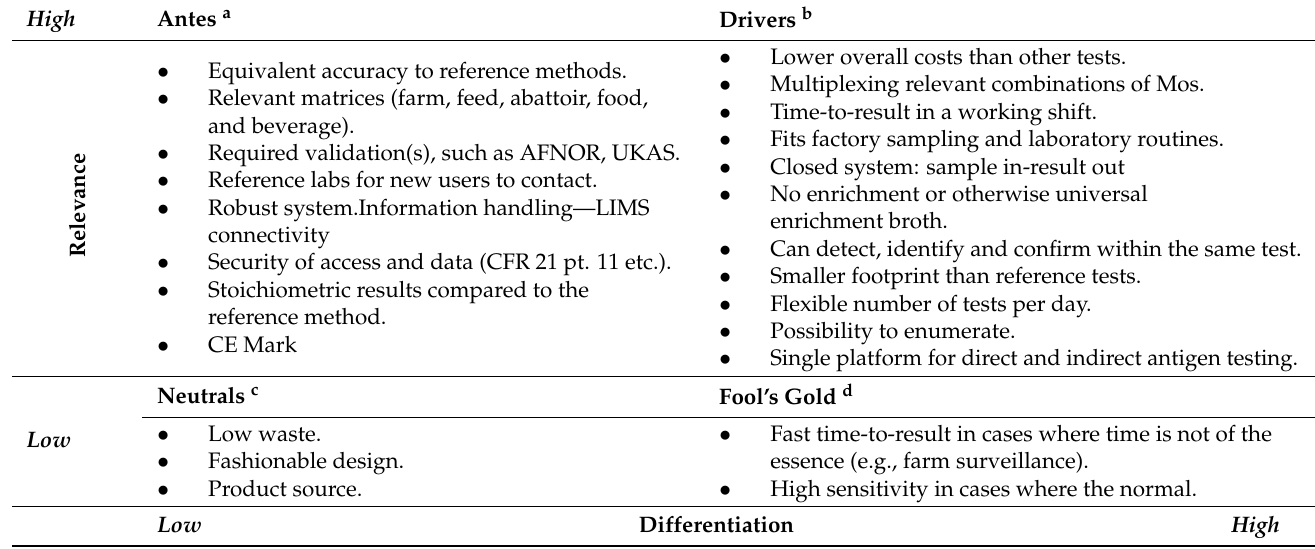
Table 5. Relevance versus differentiation criteria of (innovative, alternative) analytical food microbiology methods for routine laboratories. The various method parameters that make up the overall profile are separated into four categories that reflect their relative attractiveness to users and differentiation from assays that are already in use. The completion of the quadrants is empiric and the weight of criteria may vary between readers. High Antes a Drivers b